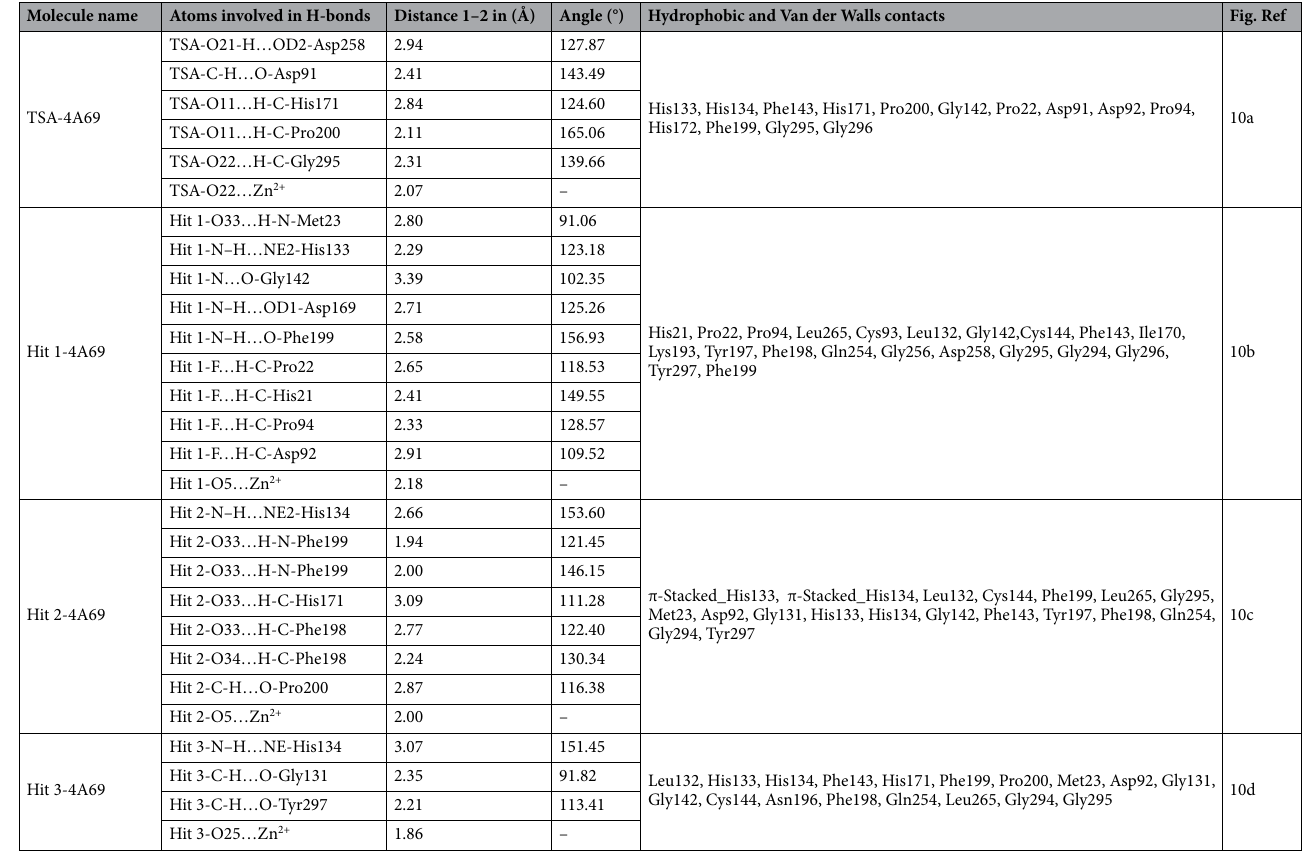
Table 5. Molecular interactions between simulated complexes of TSA and screened Hit compounds with HDAC3 (4A69.PDB).